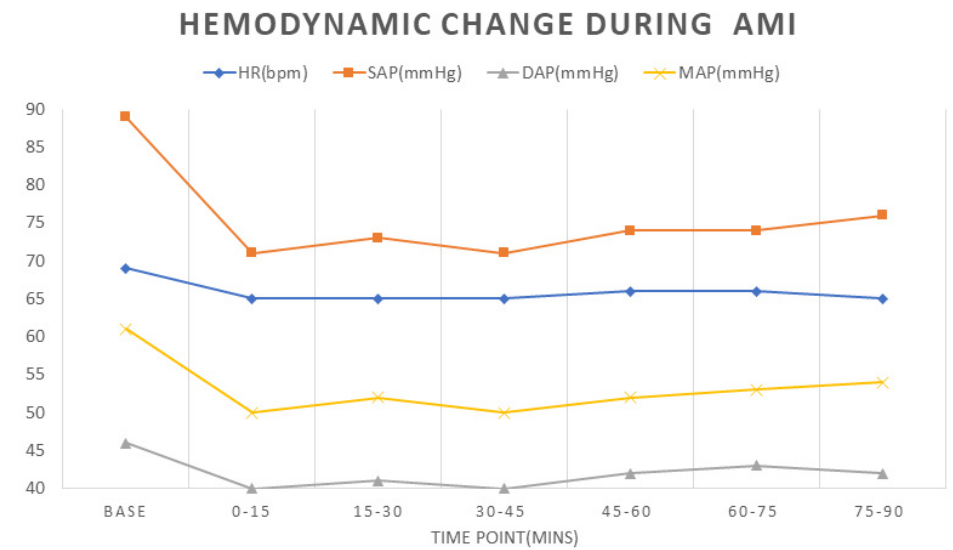
Figure 1. Heart rate and blood pressure at baseline and 15-min intervals during LAD occlusion in pigs. HR: heart rate; SAP: systolic arterial pressure; DAP: diastolic arterial pressure; LAD: left anterior descending artery; MAP: mean arterial pressure. Baseline was defined as the last reading before LAD occlusion.